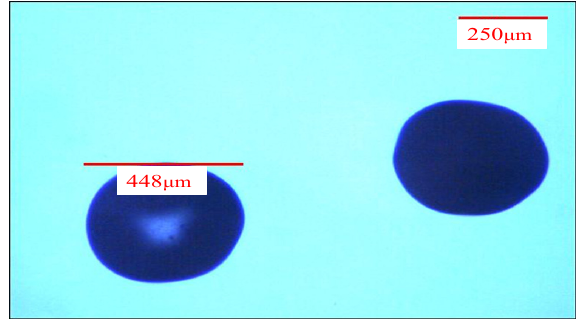
Figure 3. Microcapsules of alginate/chitosan. Sodium dodecyl sulfate (SDS) was added to make the tea tree essential oil evenly mixed with the alginate. The three-tube microfluidic device was used to prepare